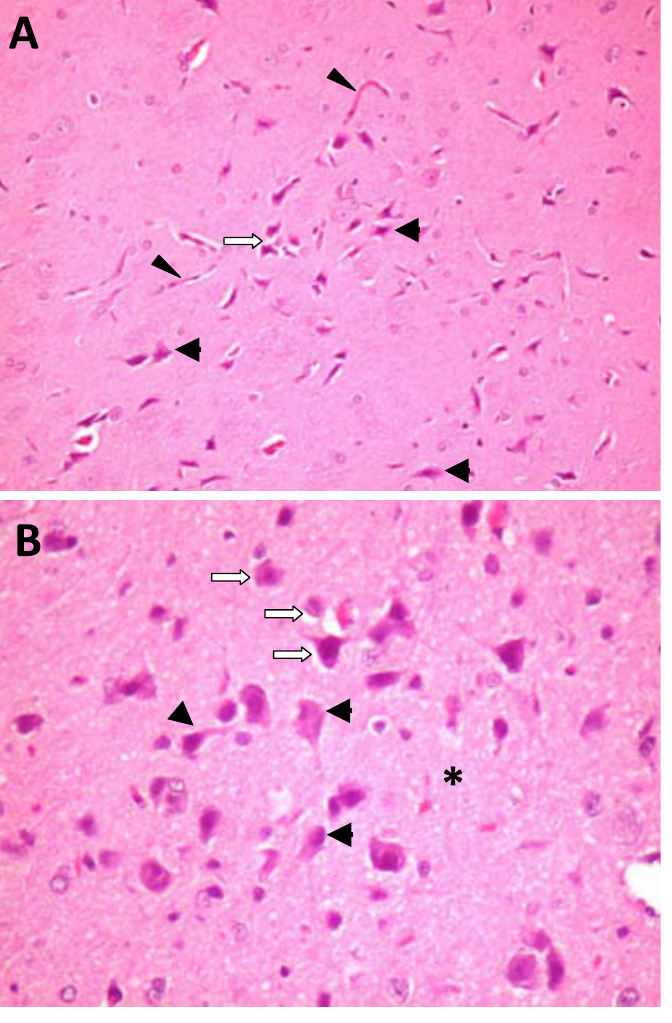
FIGURE 2 - Fotomicroscopic of cerebral hemispheric region demonstrating greater number of ischemic neurons. A : ischemic neurons (Black arrows – citoplasmatic eosinophilia, nuclear pyknosis and non evident nucleoli), perineural vacuolization (White Arrow) and vascular congestion (arrowheads). Hematoxylin-eosin 200x. B : ischemic neurons (black arrows) perineural vacuolization (white arrows) and brain edema (asterisk). Hematoxylin-eosin